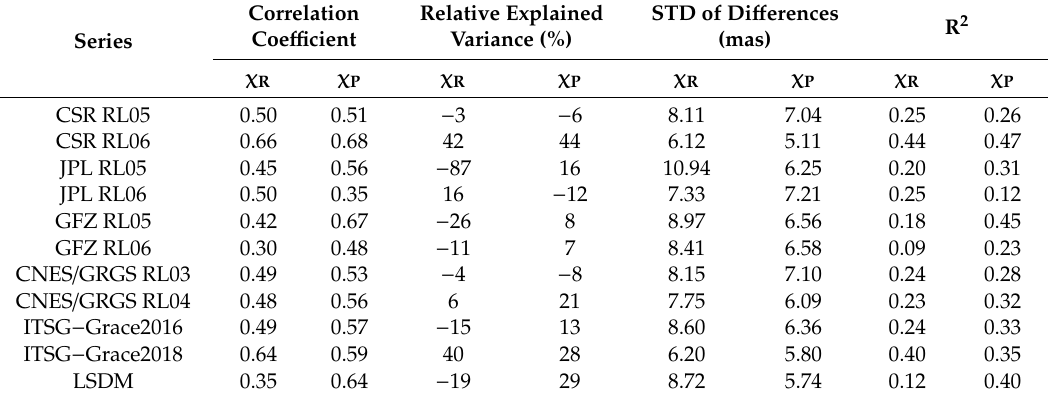
Table A3. Correlation coe ffi cients of χ R and χ P parts of non-seasonal variation between GAO and HAM computed from GRACE solutions and LSDM, the percentage of variance in GAO explained by HAM functions, standard deviation (STD) of di ff erences between GAO and HAM, and coe ffi cient of determination (R 2 ). The critical value of the correlation coe ffi cient for 25 independent points and a confidence level of 0.95 was 0.34. The standard error of the di ff erence between two correlation coe ffi cients for 25 independent points was 0.30.